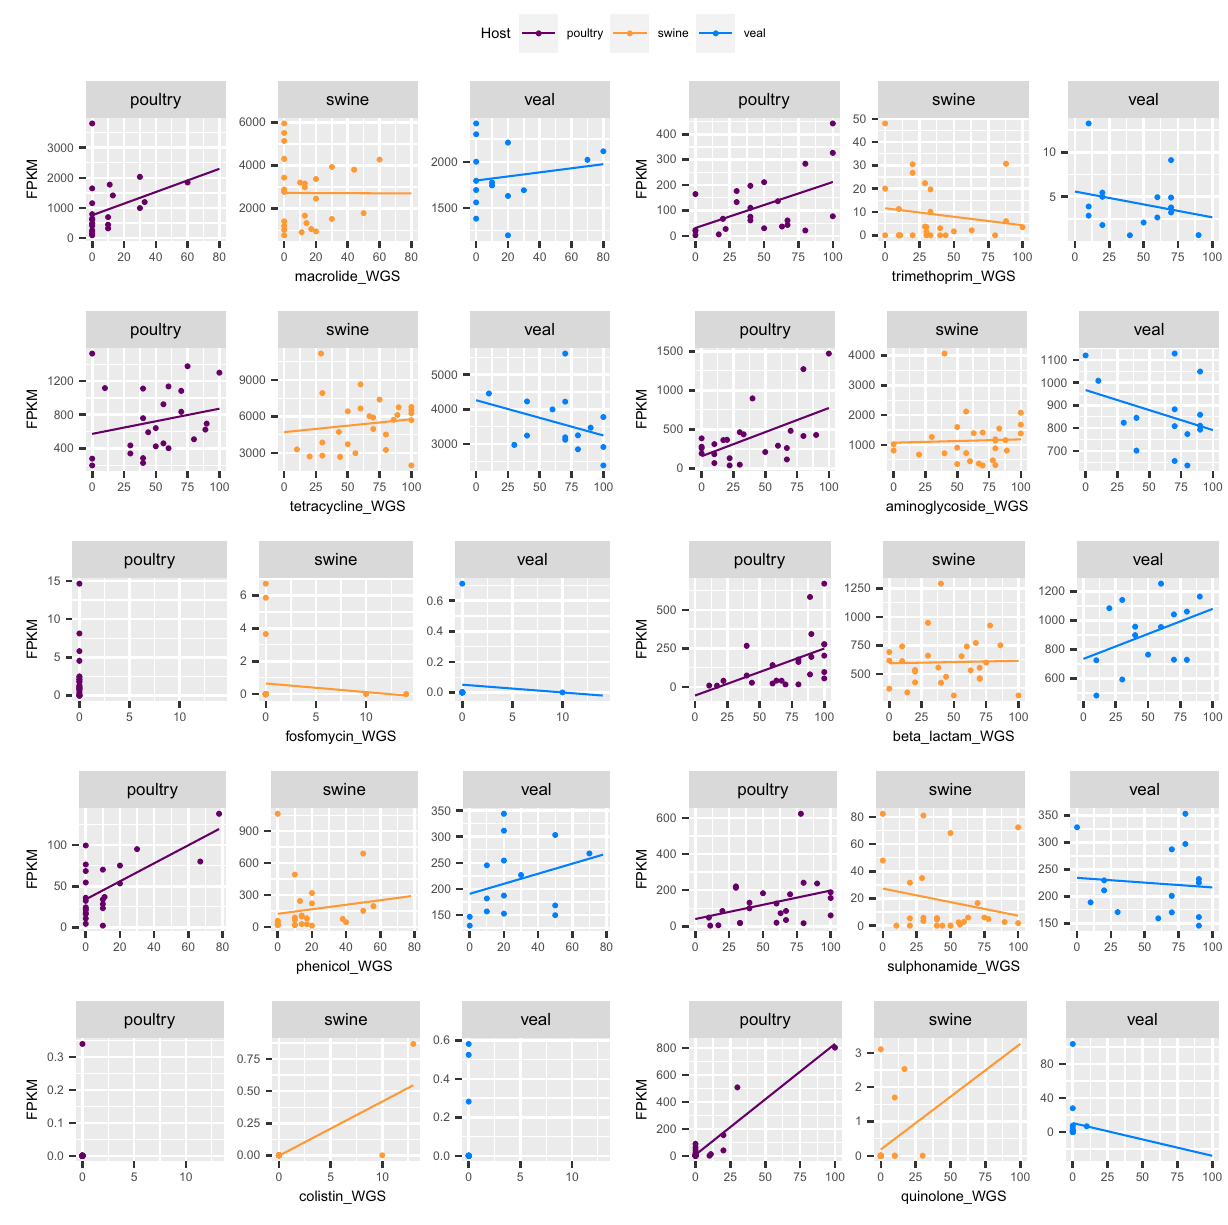
Figure 7. Scatter plot between abundance of AMR genes from metagenomic fecal samples and percentage of E. coli isolates carrying AMR genes from the same farm. X-axis is percentage of E. coli isolates carrying resistance genes. Y-axis represents abundance of resistance genes in FPKM (Fragments Per Kilo base per Million fragments) from metagenomic fecal